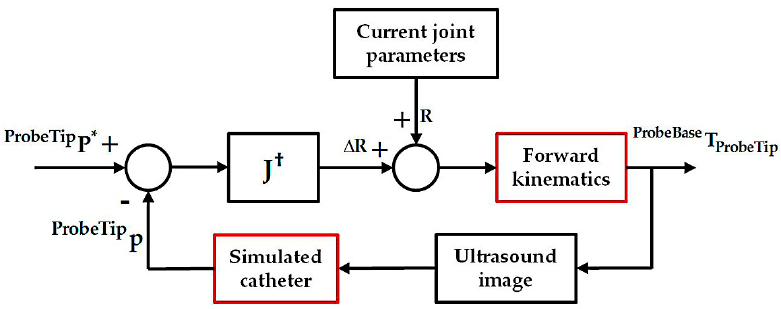
Figure 6. Overview of the simulation experiment using the Jacobian position control loop for localized adjustment with the red boxes highlighting the simulated sections. adjustment with the red boxes highlighting the simulated